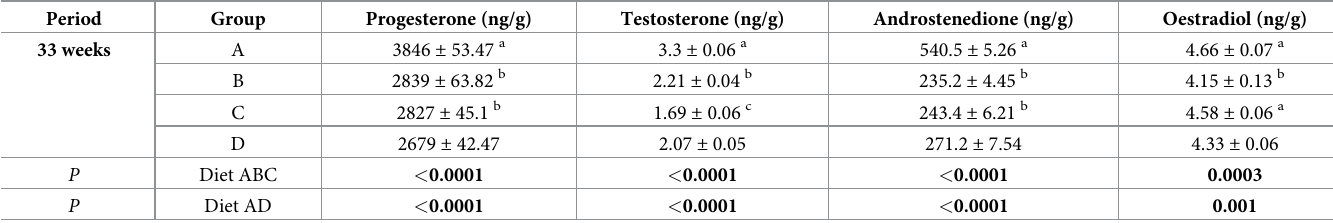
Results are presented as lsmeans ± SEM. P values and different individual letters indicate a significant effect of the diet between A, B and C groups (experiment 1) or between A and D groups (experiment 2). P value was considered as significant if P < 0.05. Thirty eggs yolk were collected from broiler hens fed with different concentrations of GSE dietary supplementation or with a control diet. A: animals fed with control diet without GSE supplementation, B and C: animals supplemented with GSE at 0.5% and 1% of the total diet composition, respectively, starting at 4 week-old until 40 week-old (experiment 1) and D: supplementation at 1% of the total diet composition starting at hatch until 40 week-old (experiment